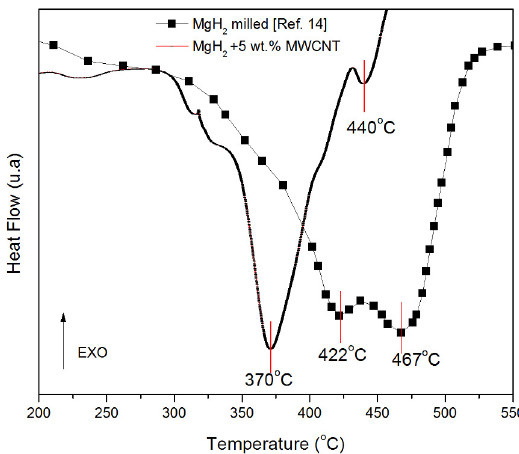
Figure 3. The DSC curves (heating rate 10 ºC/min) for the sample MgH2 + 5 wt% MWCNT and MgH2 milled for 24